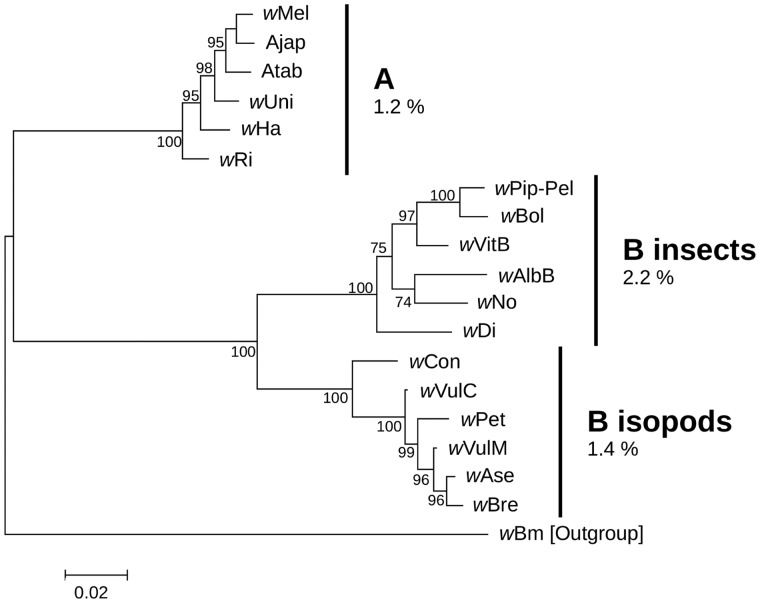
Maximum-likelihood phylogenetic tree of the 12 concatenated HR genes, based on the GTR+G model (gamma = 5) and 85% partial deletion. Bootstrap scores (%) are shown on branches (based on 1,000 replicates). The phylogenetic tree reveals three highly supported monophyletic groups, each composed of six Wolbachia strains including: Strains from supergroup A, from supergroup B hosted by insects and from supergroup B hosted by isopods. Intragroup mean distances are noted besides each group. Intergroup mean distances are: 10.2% between A and B from insects, 9.3% between A and B from isopods, and 5.9% between B from insects and B from isopods.